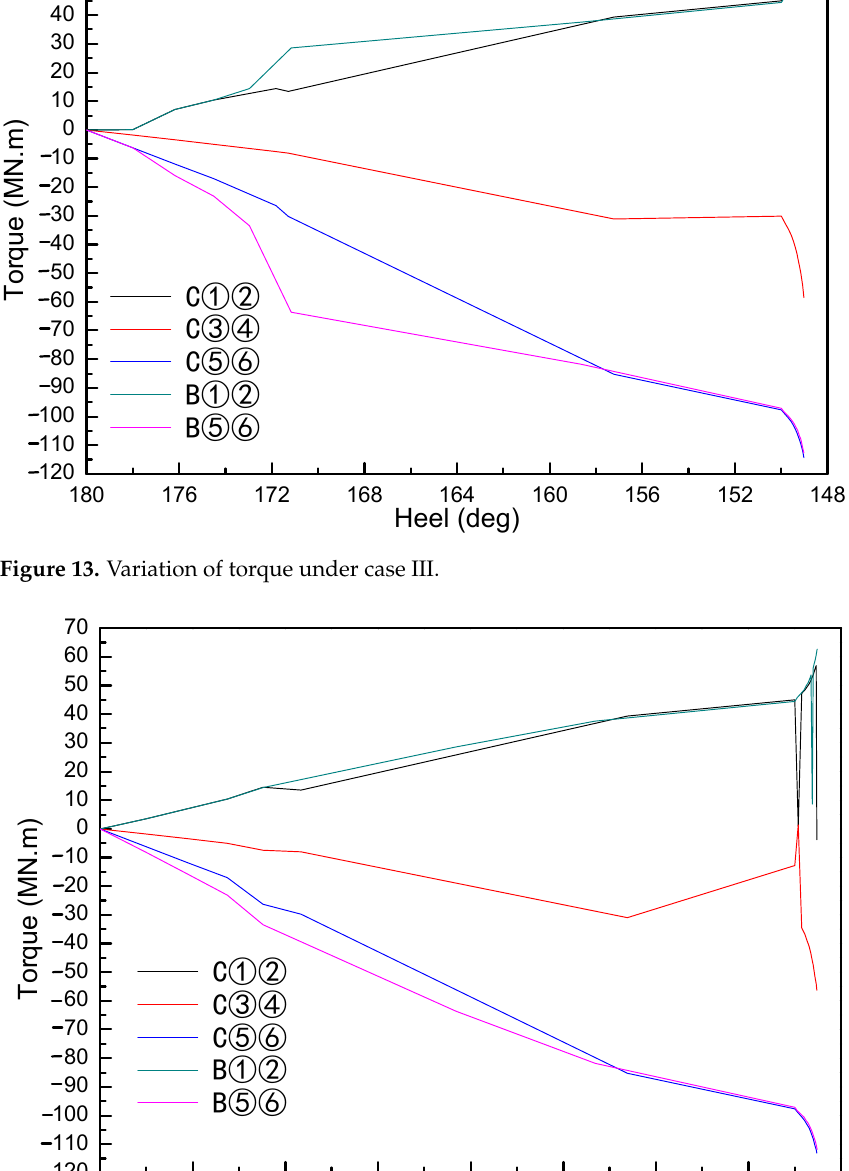
Figure 12. Variation of torque under case Ⅱ .